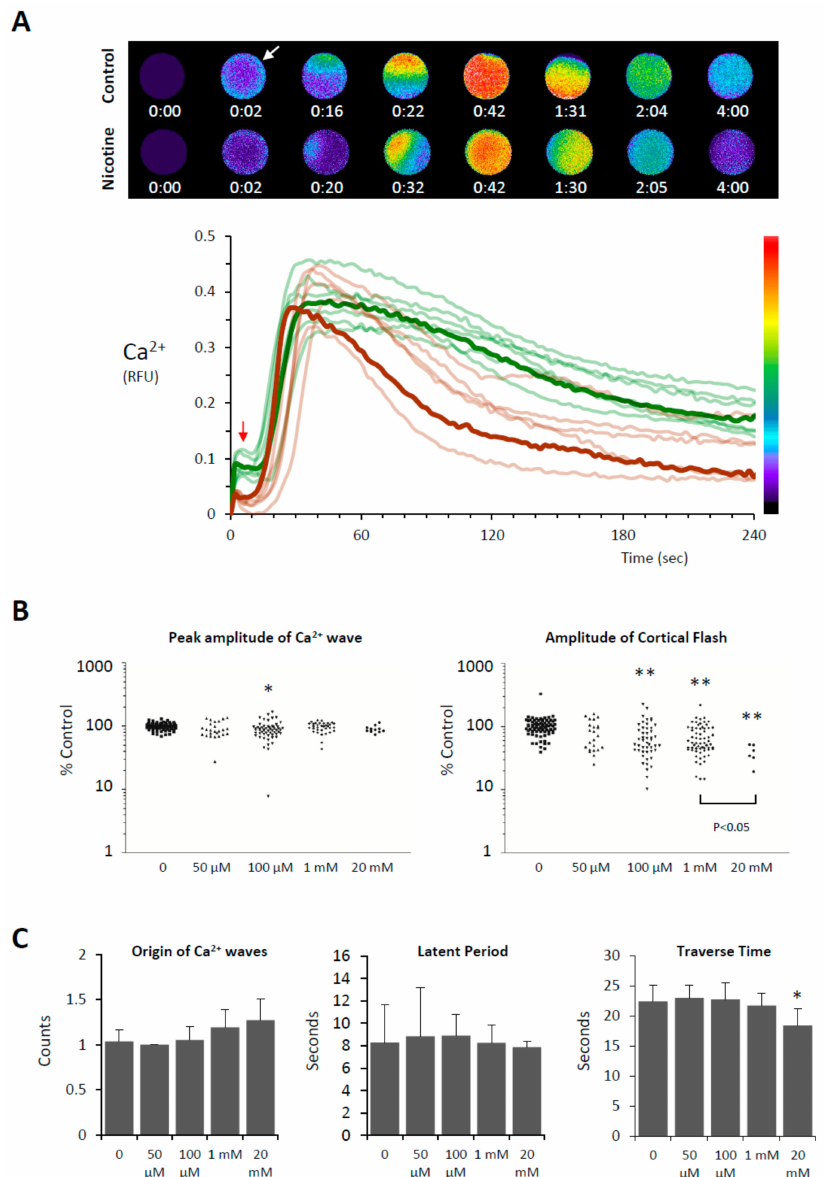
Figure 3. E ff ects of nicotine pretreatment on the Ca 2 + signaling in the fertilized eggs of P. lividus . The Ca 2 + responses in the fertilized eggs pretreated with various concentrations of nicotine (5 min) were pooled from multiple experiments comprising 5 to 8 eggs for each nicotine dose. ( A ) The pseudo-colored relative fluorescence images at the top panel represent the sites of instantaneous Ca 2 + increases at the key time points in the eggs fertilized with or without nicotine pretreatment (20 mM). The graph shows the trajectory of the intracellular Ca 2 + levels based on relative fluorescence unit (RFU) defined in Materials and Methods. Arrows indicate CF (cortical flash). ( B ) E ff ects of nicotine on the CF and the peak of the Ca 2 + wave. The peak amplitudes of CF and the Ca 2 + wave in individual eggs were normalized in reference to the corresponding average values in the control eggs (no nicotine pretreatment) from the same batch of experiment. ( C ) E ff ects of nicotine on other aspects of the Ca 2 + response at fertilization: counts of Ca 2 + wave origins, latent period (i.e., time interval between the CF and the initiation of the Ca 2 + wave), and the time required for the Ca 2 + wave to travel from the sperm interaction site to the antipode (traverse time). Values significantly di ff erent from the control (0 mM nicotine treatment, Tukey HSD): ** P < 0.001, * P <